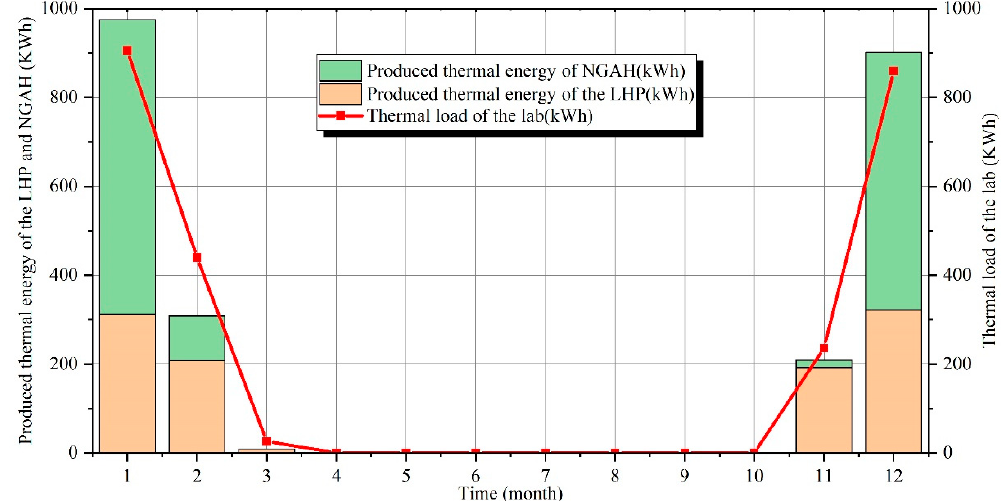
Figure 14. Produced thermal energy of natural gas auxiliary heater (NGAH) and LHP during heating mode. Table 9. Produced thermal energy in heating mode.